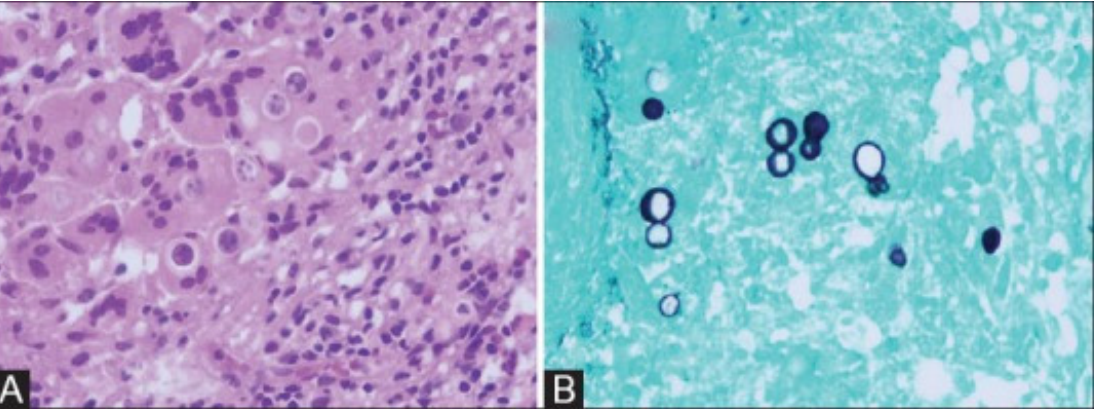
Figure 5. Characteristic Blastomyces microscopy. Hematoxylin and eosin staining of a Blastomyces- containing cerebellar mass at ×400 magnification ( A ) with large, round, thick-walled yeast cells. containing cerebellar mass at × 400 magnification ( A ) with large, round, thick-walled yeast cells. Grocott’s methenamine-silver-stained section of the same mass at ×400 magnification ( B ) with Grocott’s methenamine-silver-stained section of the same mass at × 400 magnification ( B ) with broad- broad-based budding yeast cells. Image source is Kochar et al. 2016, used under a creative commons based budding yeast cells. Image source is Kochar et al., 2016, used under a creative commons license license (CC BY-NC-SA 3.0) [92]. (CC BY-NC-SA 3.0)